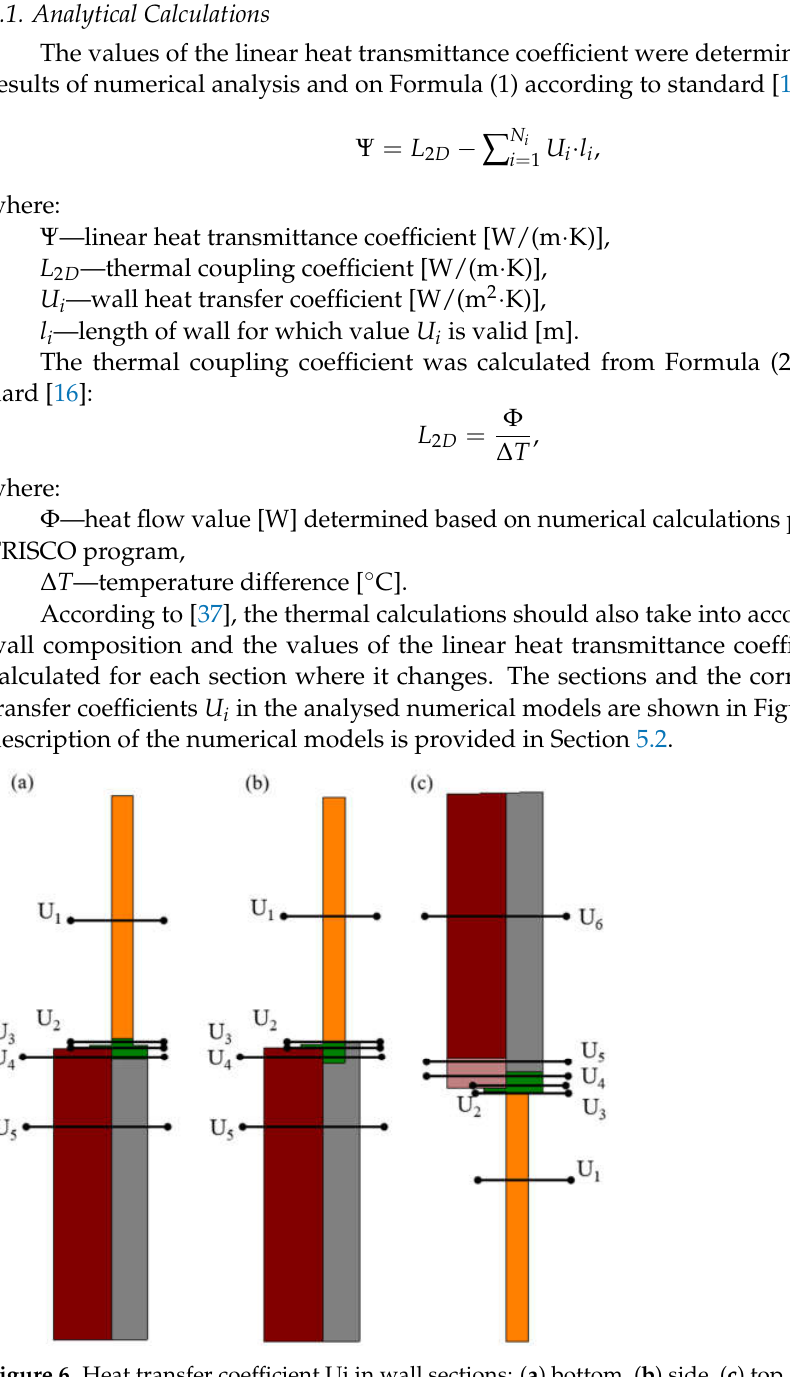
Figure 6. Heat transfer coefficient Ui in wall sections: ( a ) bottom, ( b ) side, ( c ) top.